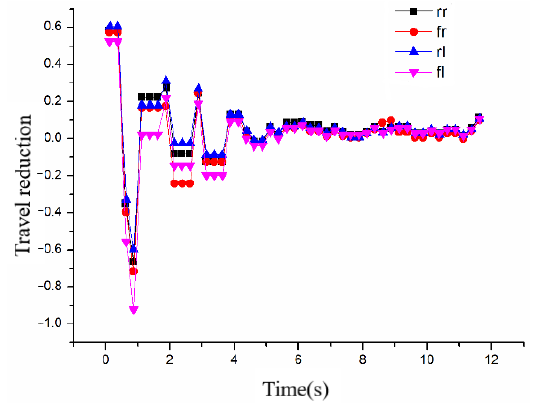
Figure 14. Travel reduction of incremental PI strategy.